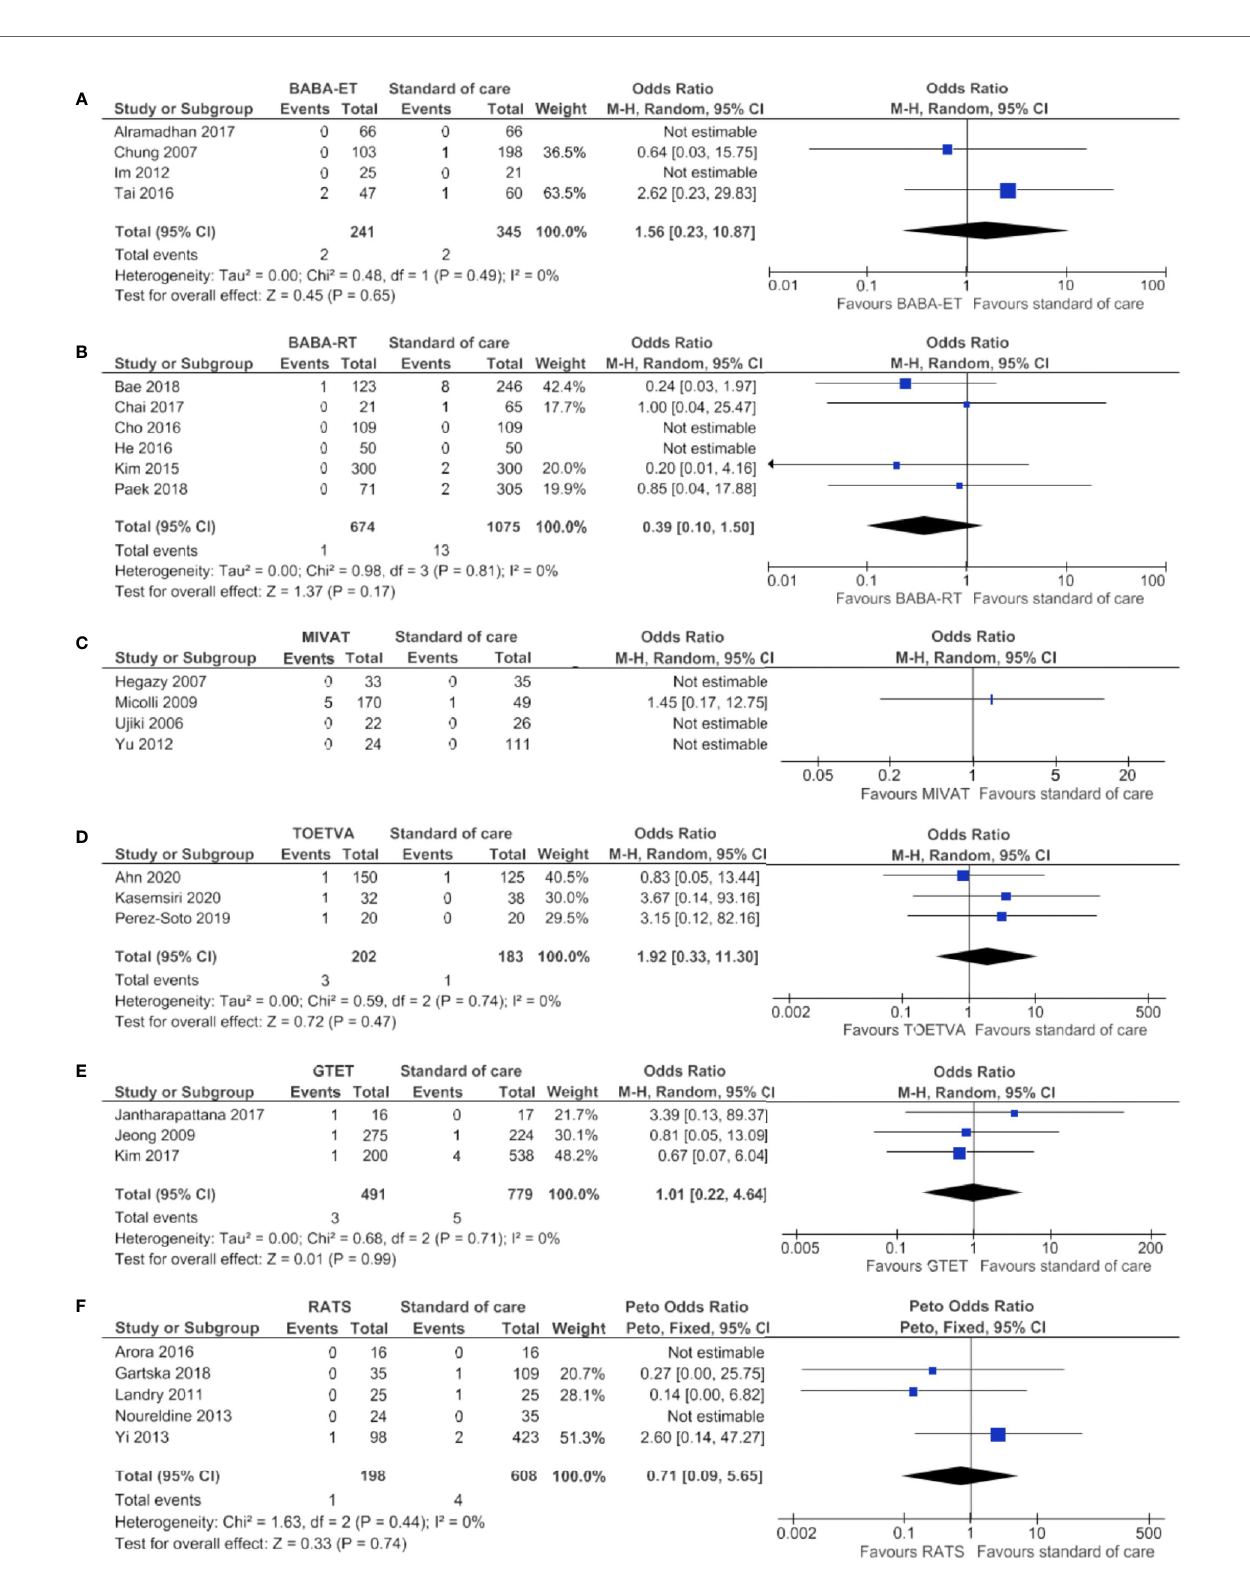
FIGURE 6 | Forests plots of permanent recurrent laryngeal nerve injury for (A) BABA-ET, (B) BABA-RT, (C) MIVAT, (D) TOETVA, (E) GTET and (F)